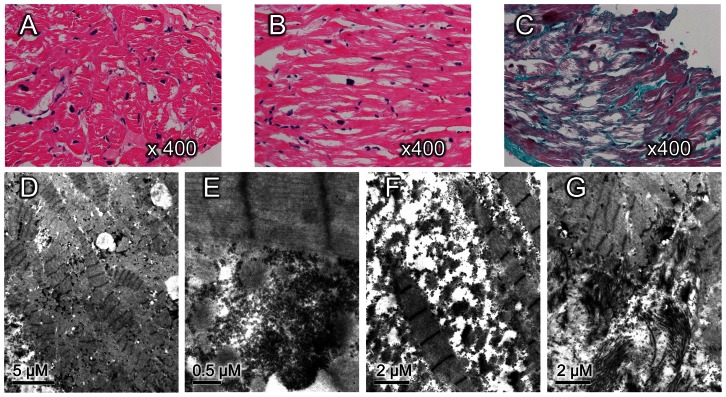
Histopathology of ventricular sections obtained from the proband.(A) Cross section of ventricular myocardium shows hypertrophied myocytes with profound intracellular vacuolation and marked variation in the nucleus size (hematoxylin and eosin staining, original magnification × 400). (B) Myocardial fibers in longitudinal section shows loss of the normal parallel arrangement, increased side-branching, and frequent side-to-side branches connections (hematoxylin and eosin staining, original magnification × 400). (C) Masson’s trichrome staining shows increased interstitial fibrosis with blue color (original magnification × 400). (D) Electron microscopy shows angulated myofibrillar with length-heterogeneity sarcomere lengths and excess mitochondria (bar = 5 µm). (E) Granular glycogen accumulation in the subsarcolemmal regions of cardiac myocytes (bar = 0.5 µm). (F) Myofibrillar dissolution and widening of intermyofibrillar spaces in which scattered glycogen granules and mitochondria are seen (bar = 2 µm). G, Prominent interstitial fibrosis and myofibrillar disarray (bar = 2 µm).